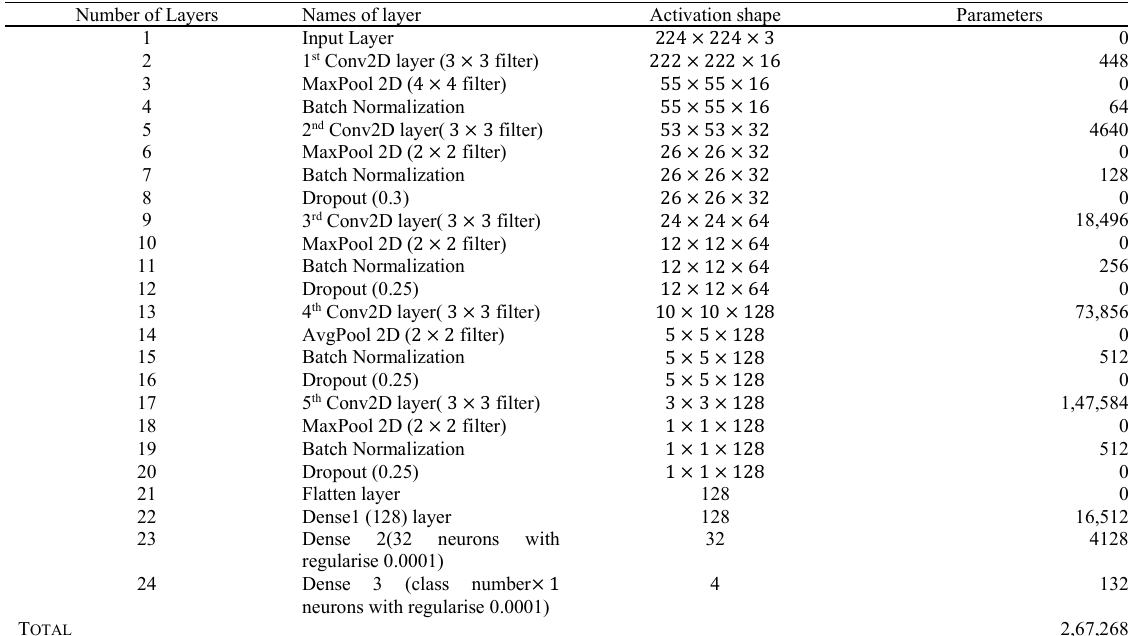
Fig. 3 Proposed CNN architecture model TABLE 3 A LL T HE L AYERS IN T HE CNN M ODEL WITH P ARAMETERS AND A